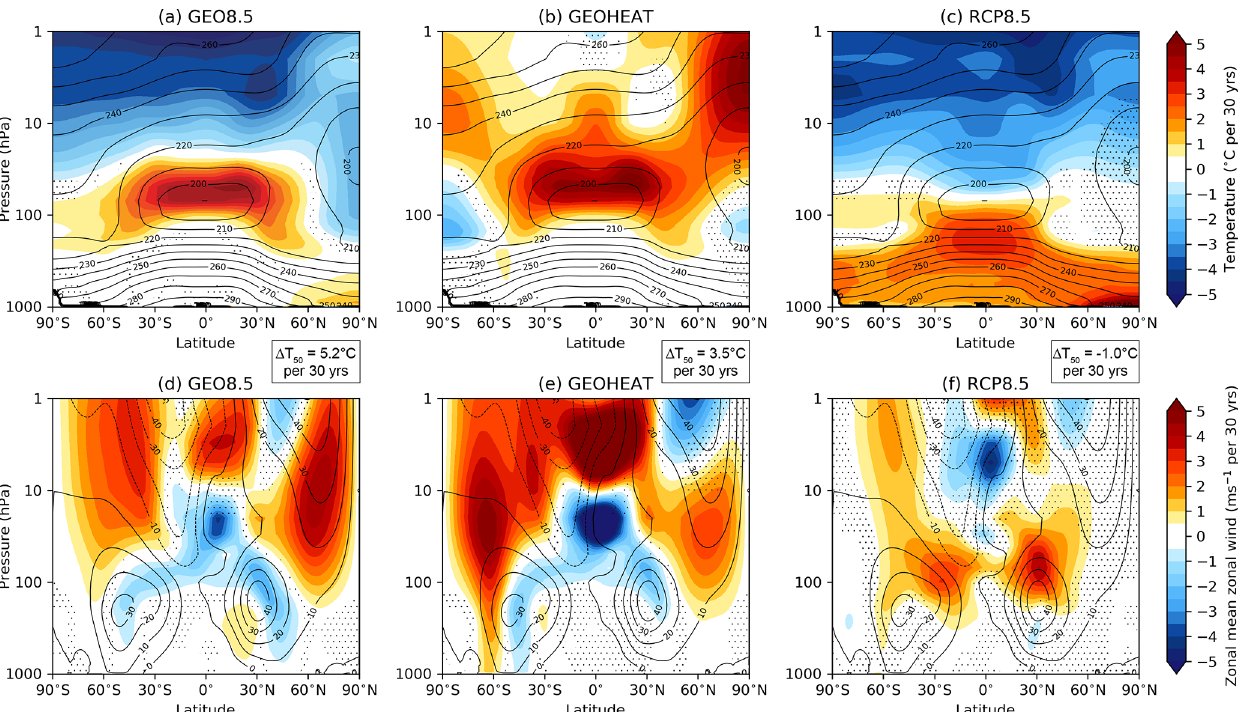
Figure 3. Trends in DJF zonal mean temperature and zonal winds. Shown are ensemble mean linear trends in temperature ( a–c ; shading; degrees Celsius per 30 years) and zonal wind ( d–f ; shading; meters per second per 30 years). Responses are shown for (a, d) GEO8.5, (b, e) GEOHEAT and (c, f) RCP8.5. Contours show the Base climatology (2010–2030). Stippling indicates trends that are not statistically significant at the 95% confidence level under a one sample, two-sided Student’s t test using the standard deviation across ensemble members. (cid:49)T 50 values for each experiment give the ensemble mean and tropical average temperature trend (30 ◦ S–30 ◦ N) minus the NH polar cap average trend (60–90 ◦ N) at